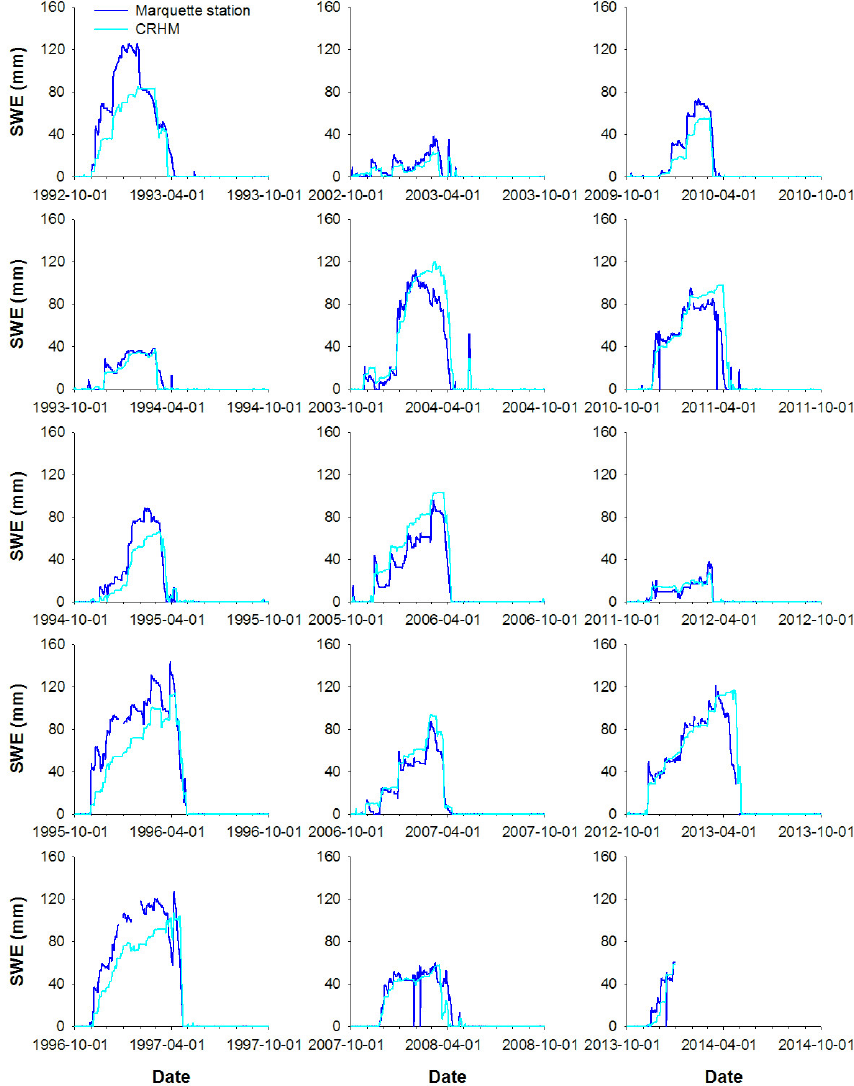
Figure 6. Comparison of observed and simulated snow water equivalent (SWE) between 1992 and 2013 for years with good records in the HYDAT database. SWE was calculated assuming a snow density of 180 kg m − 3